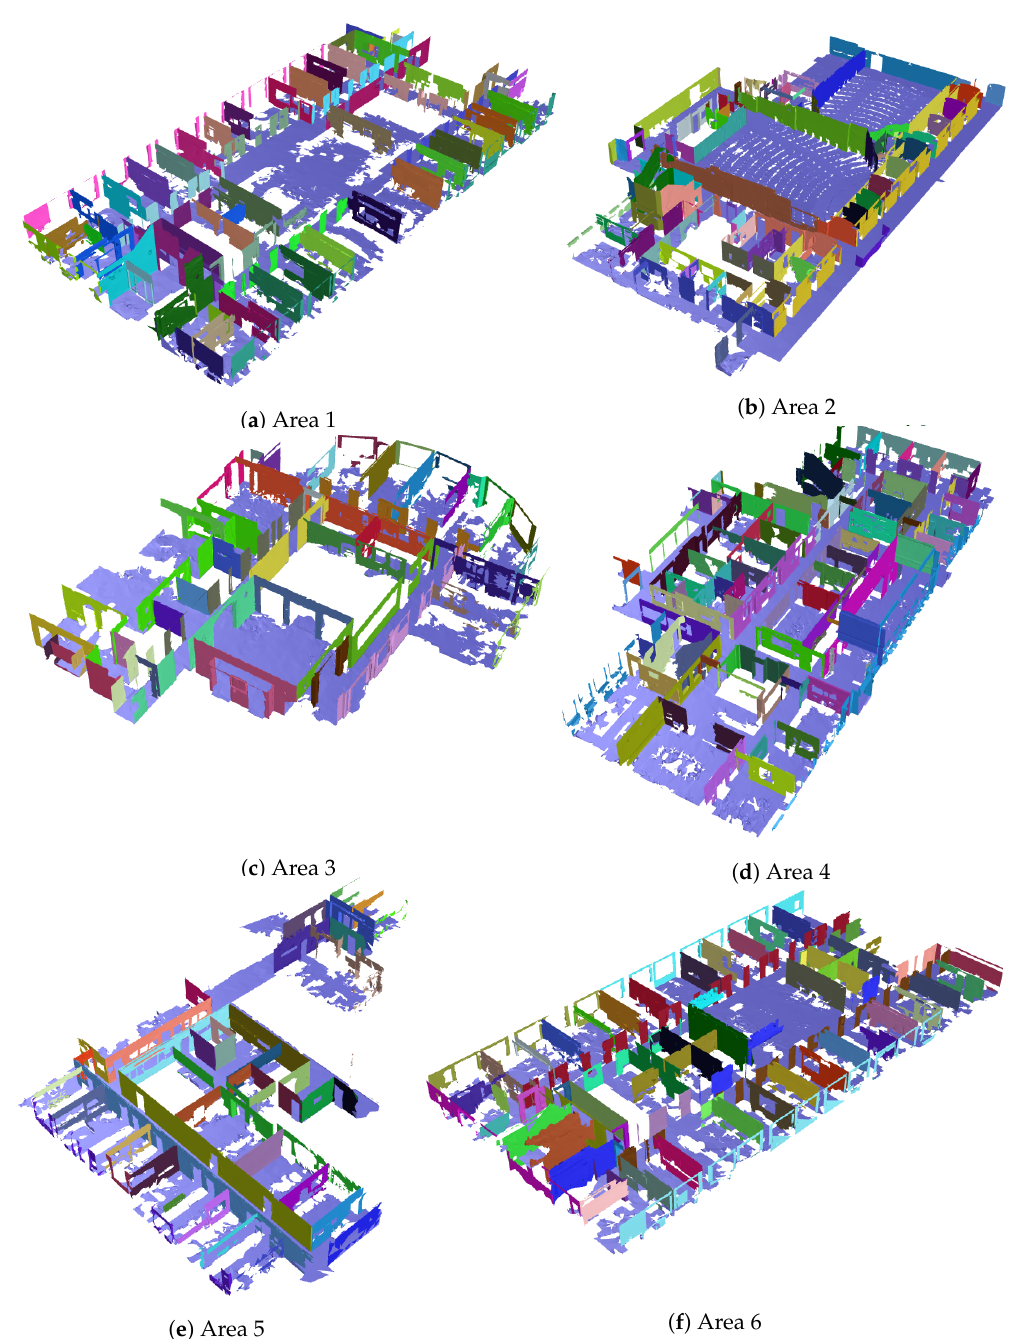
Figure 7. Overview of the results of the proposed CRF clustering algorithm. Each wall extracted from the connected components is shown in a different color. Valid connected components and singular walls are not